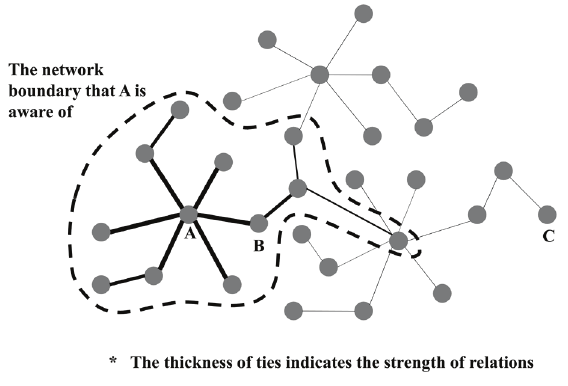
Fig. 2. The myopic view phenomenon in a